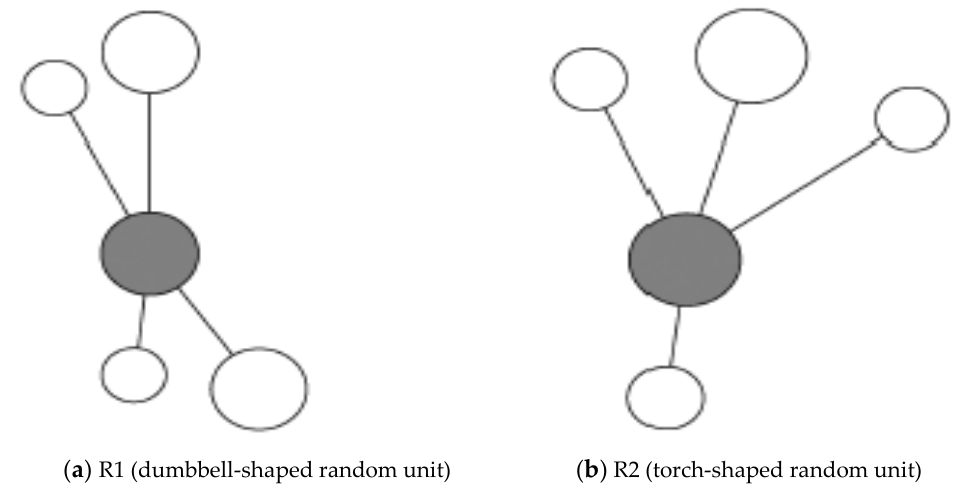
Figure 1. The random tree was classified by different distributions of angles.